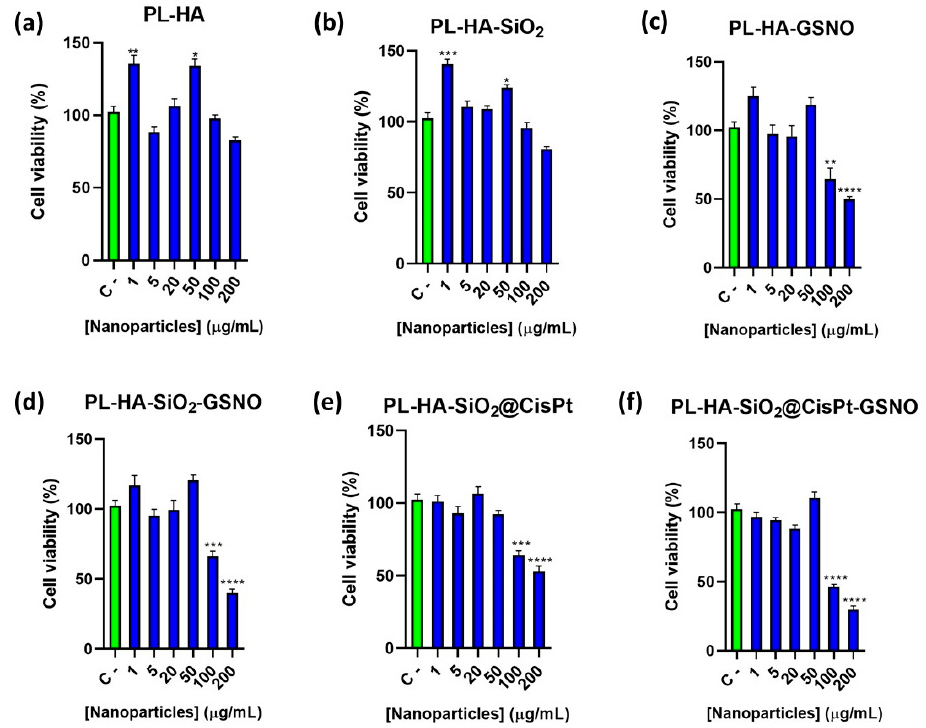
Figure 7. Viability of MDA-MB-231 cells treated with different concentrations of PL-HA ( a ), PL-HA- SiO 2 ( b ), PL-HA-GSNO ( c ), PL-HA-SiO 2 -GSNO ( d ), PL-HA-SiO 2 @CisPt ( e ), and PL-HA-SiO 2 @CisPt- GSNO ( f ). Green columns indicate the control group and blue columns indicates the treatments. Error bars indicate the standard error (SE) and asterisks indicate significant difference ( p < 0.05) between the treatments and control, calculated by ANOVA one-way. * p < 0.05, ** p < 0.02, *** p < 0.0007, and **** p < 0.0001.